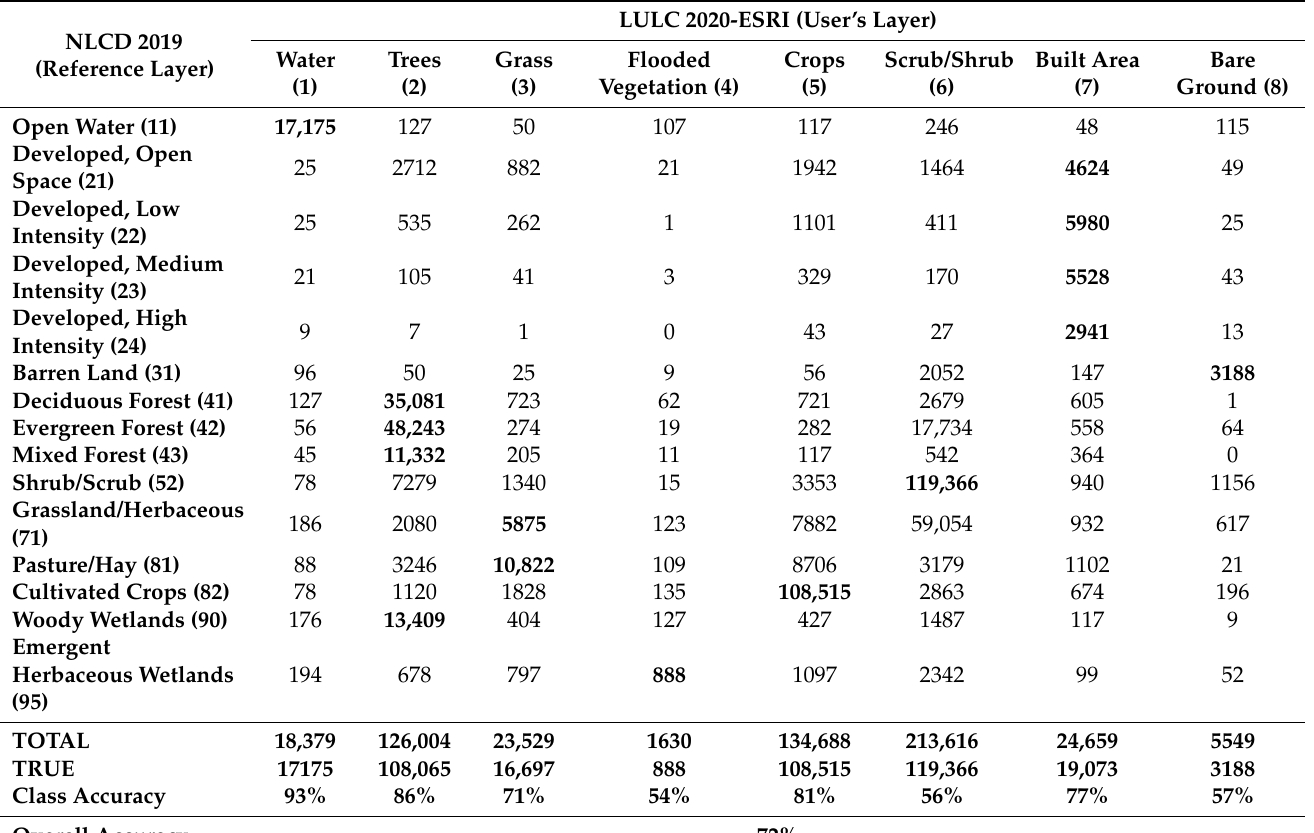
Table 4. Accuracy Assessment-Confusion